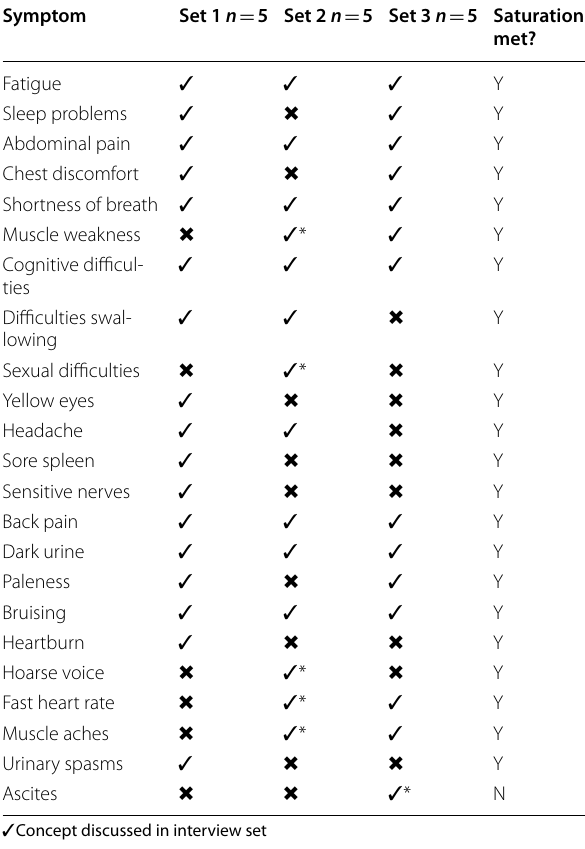
Table 3 Concept saturation analysis